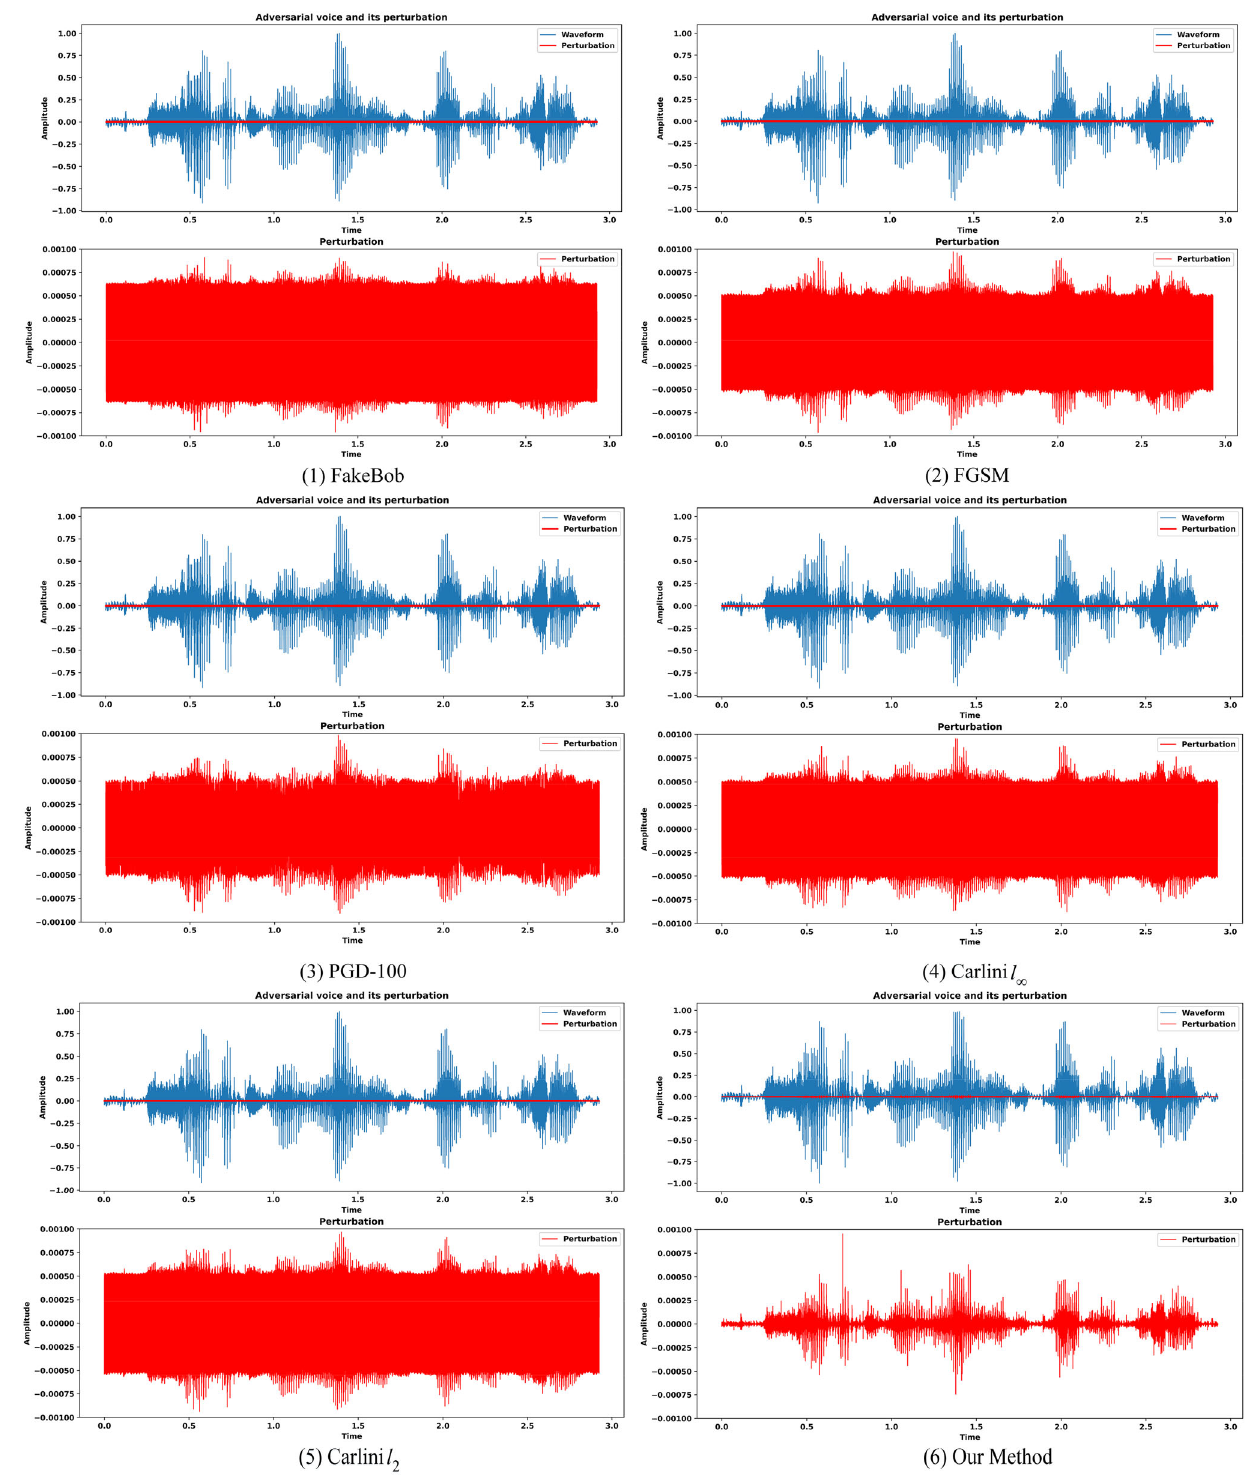
Fig. 2 Comparisonoftheproposedmethodw.r.t.thebaselinesonadver- sarial attacks of CSI. In each subgraph, the top one is an overview of the adversarial waveform (i.e., the blue line represents perturbed waveform and the red line represents the perturbations), while the bottom one is